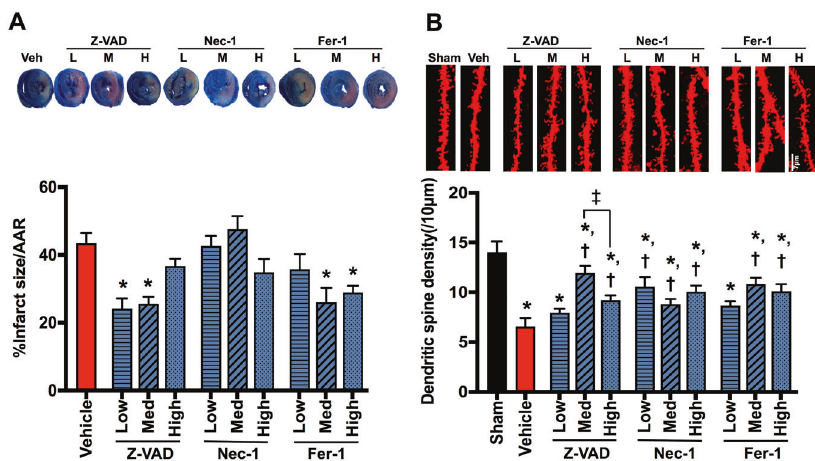
Fig. 1 The effects of cell death inhibitors on myocardial infarct size and hippocampal dendritic spine density. A Representative images of heart slices using Evans blue-TTC staining (upper panel) and quantitative evaluation of myocardial infarct size/AAR (lower panel, n = 6/group); B representative images of dendritic spine density (upper panel) and the number of dendritic spines per 10 μ m dendrites at hippocampal CA1 region (lower panel, n = 8 – 12/group, 2 – 3 slides/sample). Data are shown as mean ± SEM. * P < 0.05 vs. Sham, † P < 0.05 vs. Cardiac I/R + Vehicle, ‡ P < 0.05 vs. medium dose of Z-VAD. Veh: cardiac I/R rats treated with vehicle; L: cardiac I/R rats treated with low dose of cell death inhibitor; M: cardiac I/R rats treated with medium dose of cell death inhibitor; H: cardiac I/R rats treated with high dose of cell death inhibitor. AAR area at risk, I/R ischemia/reperfusion